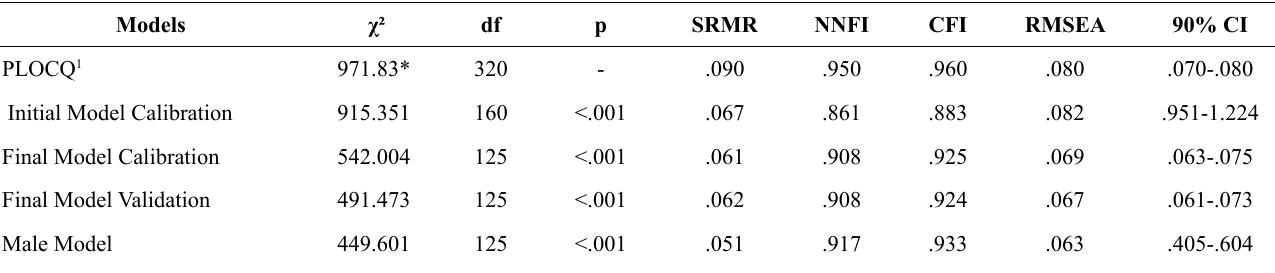
Table 2 Fit indices of the measurement models of PLOCQp (including existing versions)